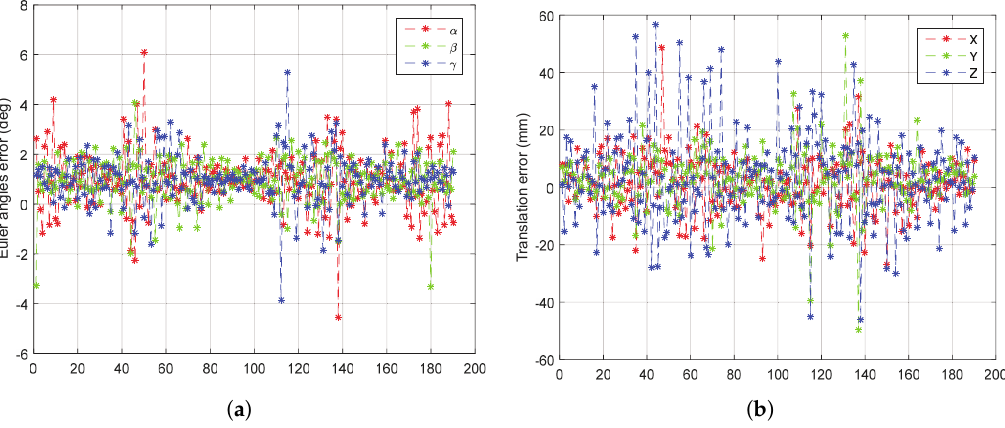
Figure 16. The error curve of ( a ) rotation and ( b ) translation of field